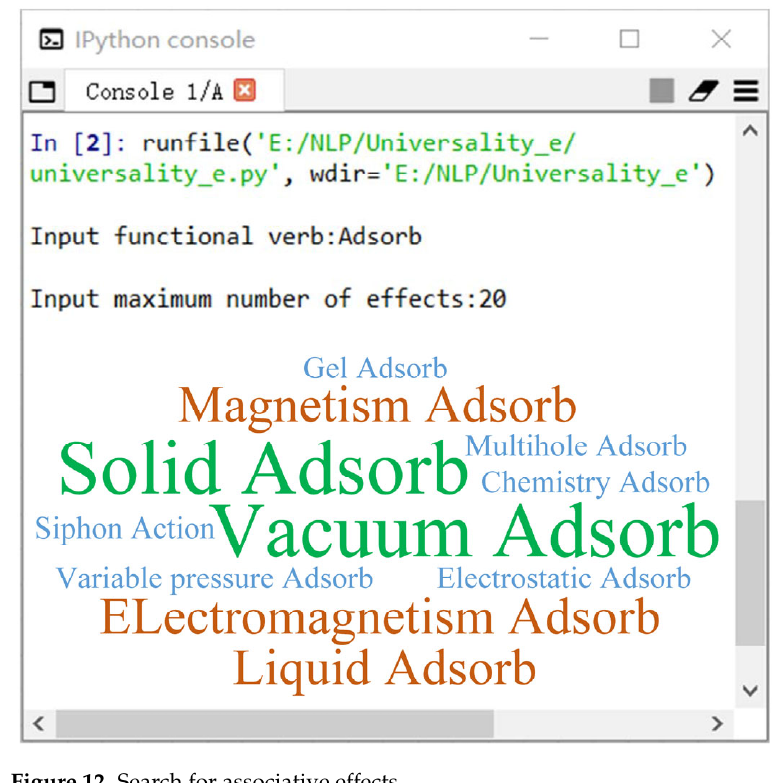
Figure 12. Search for associative effects.